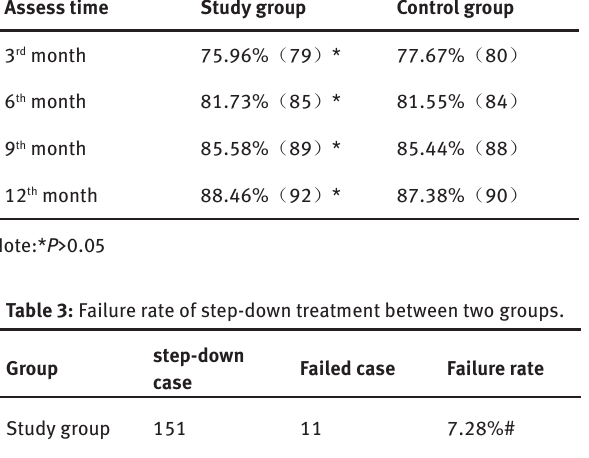
Table 2: Rate for completely controlled asthma in the two groups (%, n).